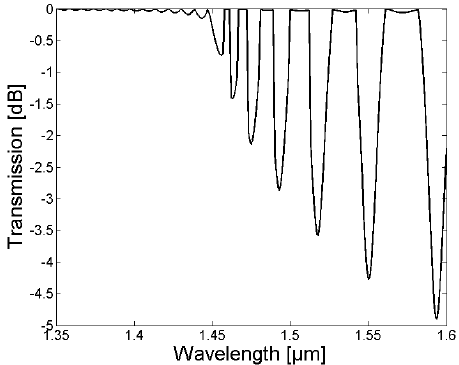
Figure 2. The resulting simulated long ‐ period fiber grating (LPG) spectrum of an untreated SM1500 single ‐ mode fiber with a grating period of 100 μ m, a grating length of 8 mm and a refractive index modulation of δ n = 1 × 10 − 3 .